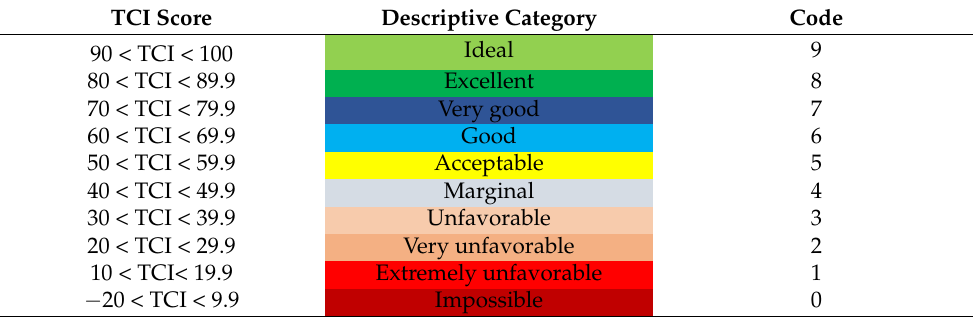
Table 2. The TCI Classification Scheme adopted from Mieczkowski (1985)